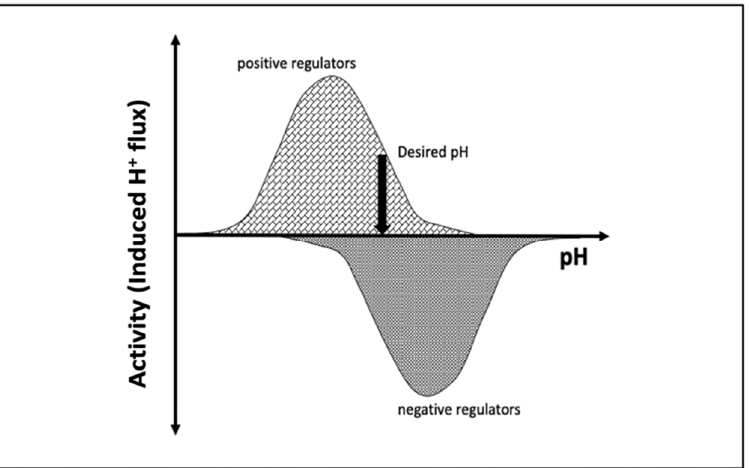
Figure 1. Schematic representation of the induced H + flux of positive (increase pH) and negative (decrease pH) regulators. The vertical arrow indicates the desired pH, at which the total induced H + flux is zero .